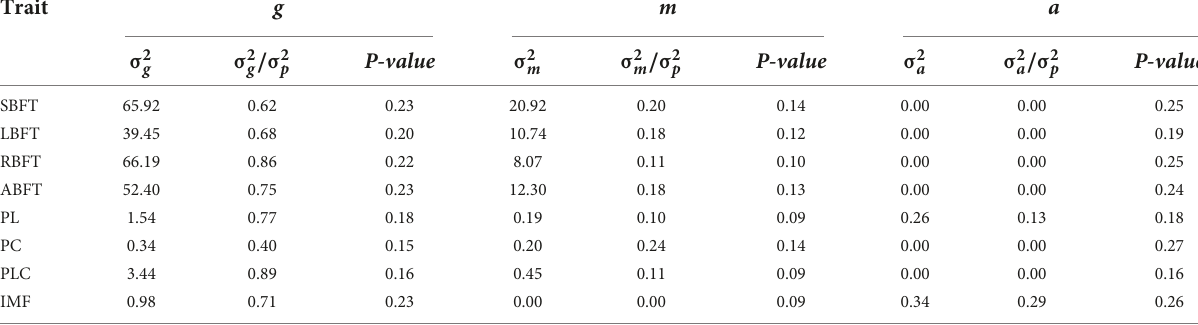
TABLE 2 Host genetics and gut microbiome effects for fat deposition traits. Trait